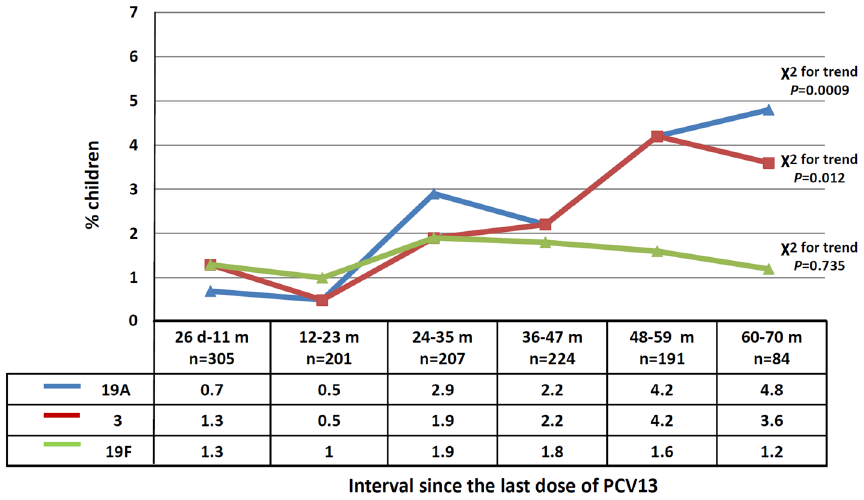
Figure 4. Percentage of colonized children with serotypes 19A, 3 and 19F according to time elapsed since the 4th (booster) dose. There is a significant increase of colonization of serotypes 19A and 3 with increasing time interval.